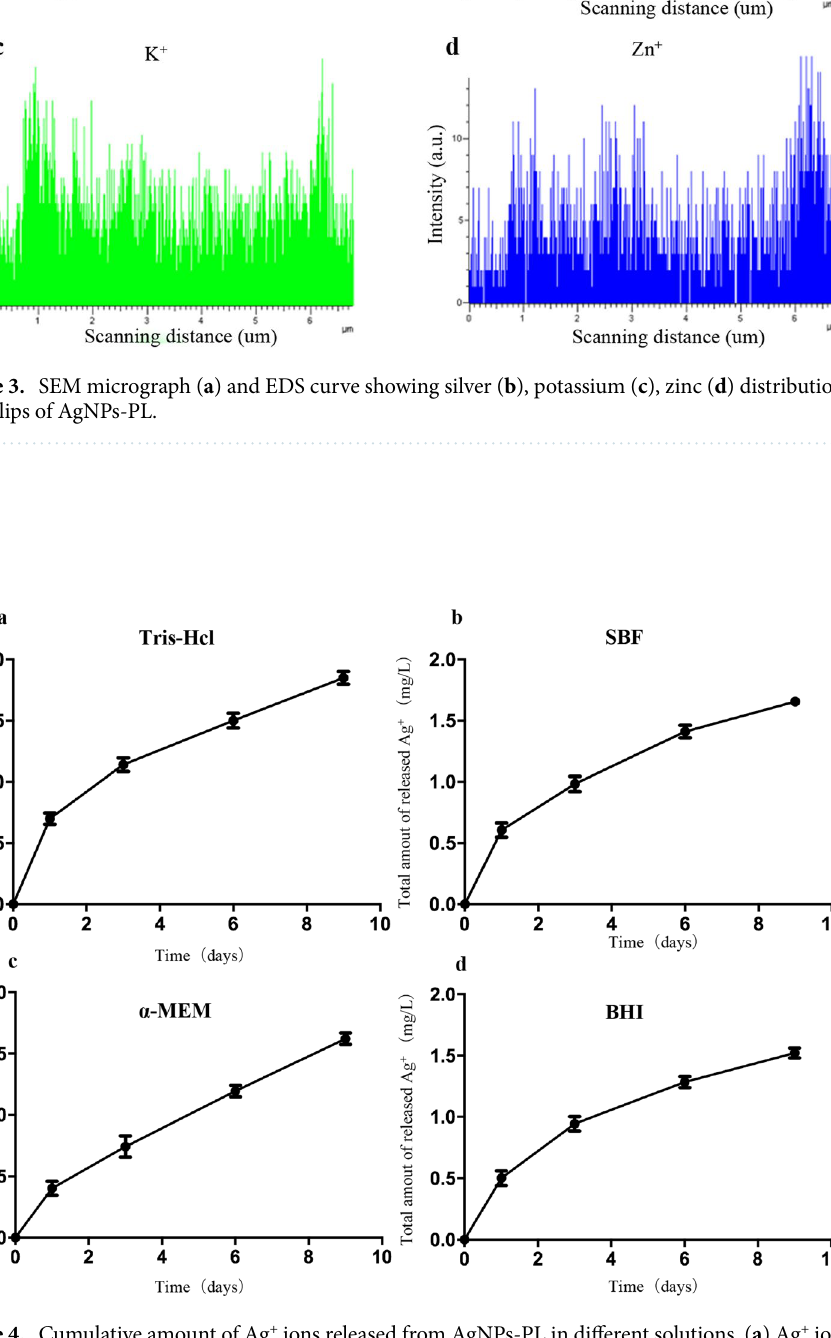
Figure 4. Cumulative amount of Ag + ions released from AgNPs-PL in different solutions. ( a ) Ag + ions released in Tris–HCL; ( b ) Ag + ions released in SBF; ( c ) Ag + ions released in α-MEM; ( d ) Ag + ions released in